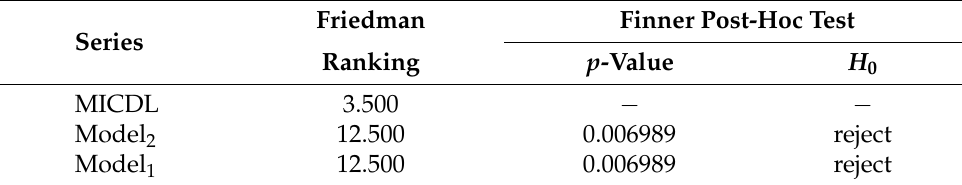
Table 11. FAR test and Finner post hoc test based on the GM metric.